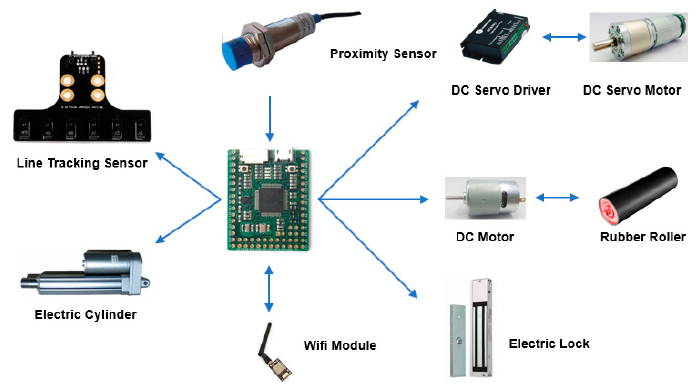
Figure 5. Block diagram of the control system in the proposed system.